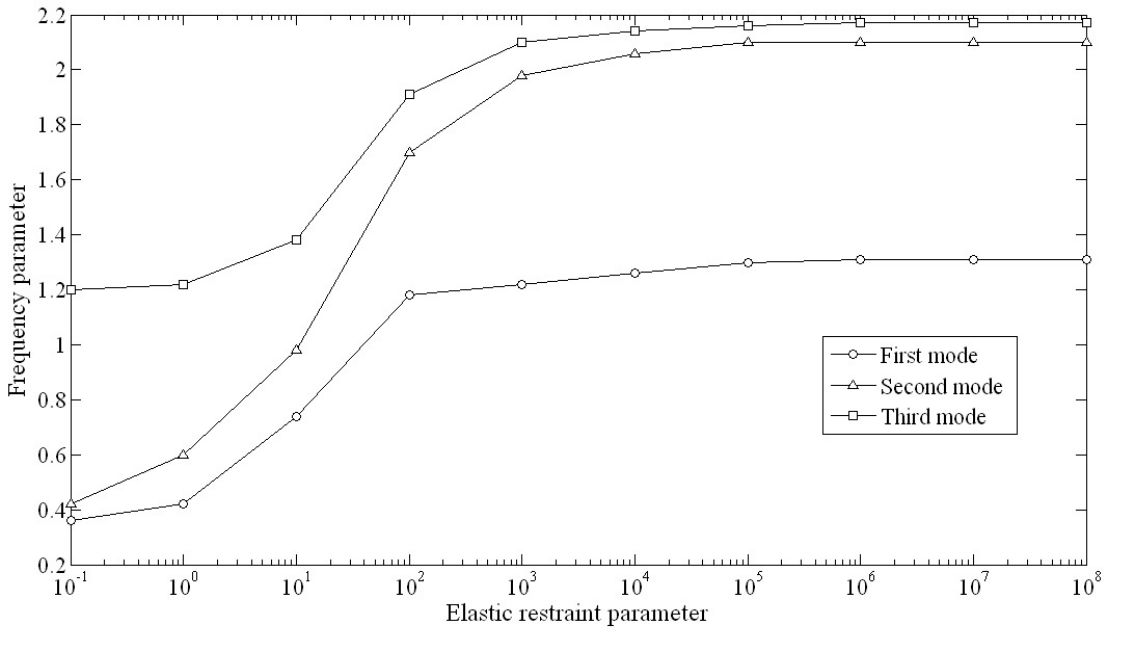
Figure 3. Fundamental frequencies parameter for a cross-ply laminated plate with one edge clamped and other three edges elastically support ( h/a = 0 . 2